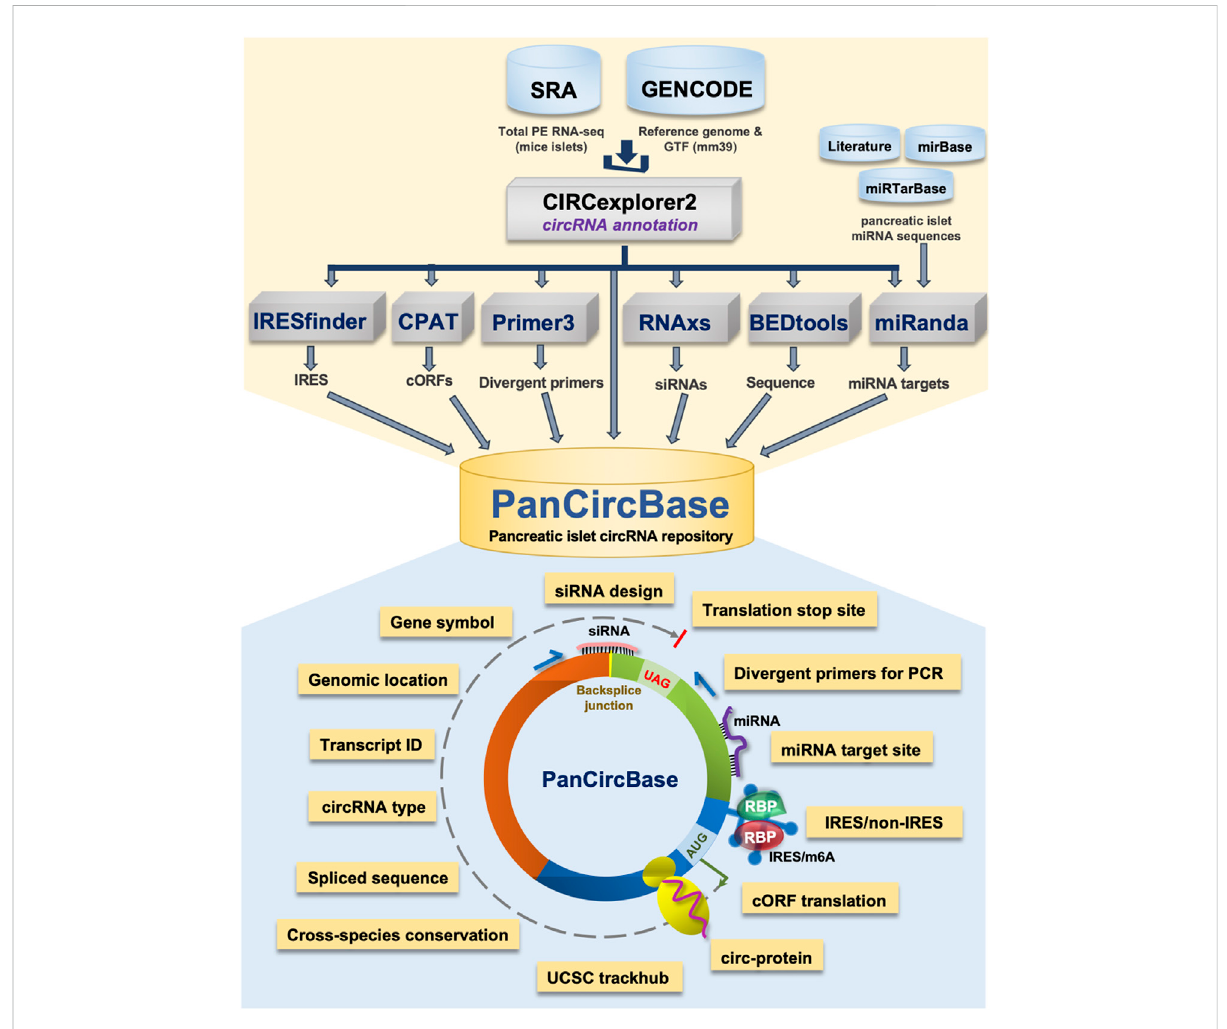
FIGURE 1 The framework of pancreatic islet circRNA database “ PanCircBase ”